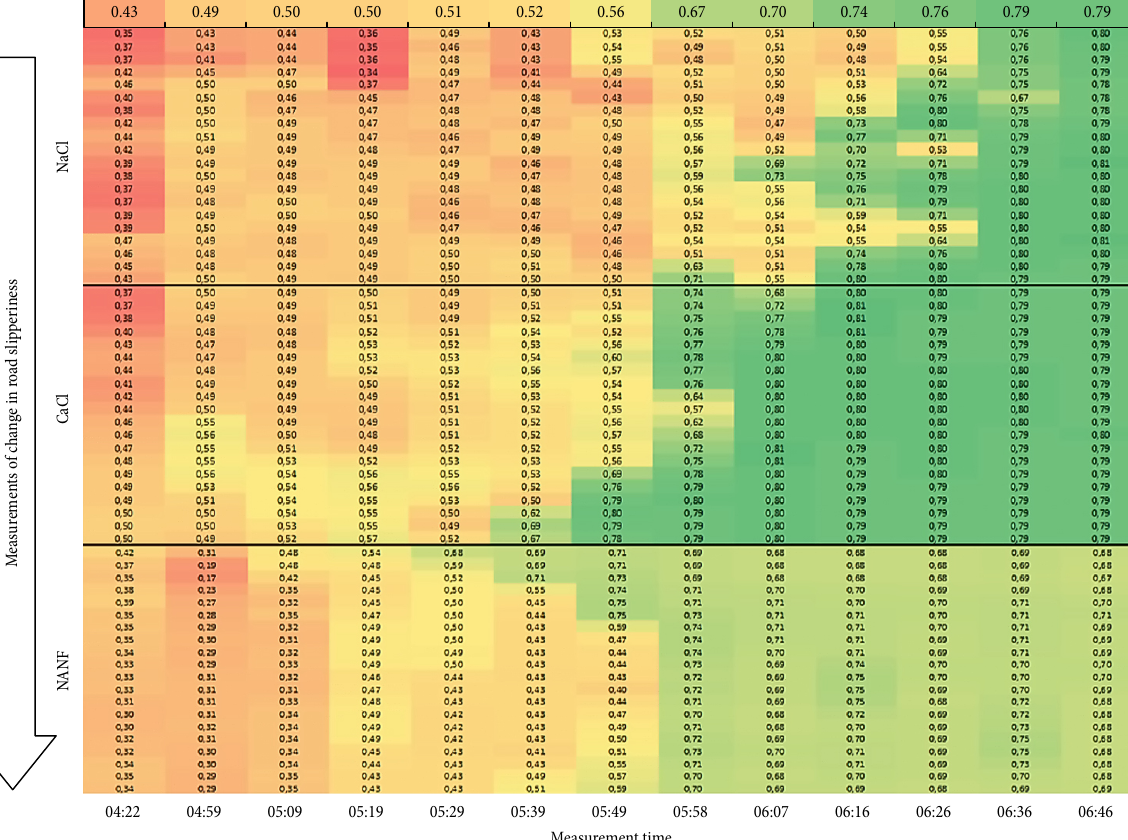
Fig. 6. Results and analysis of field